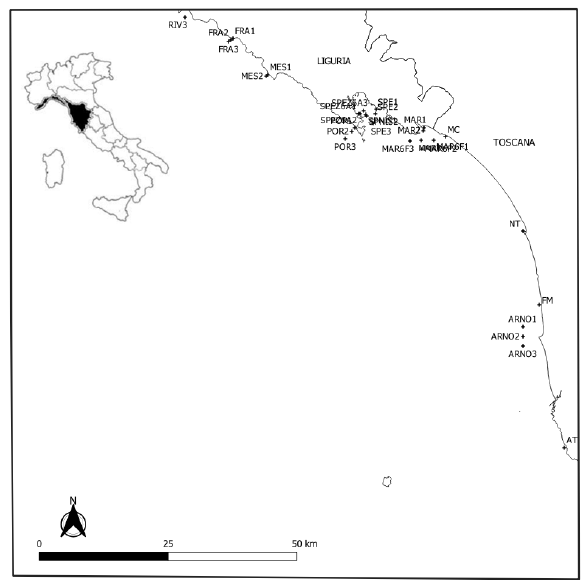
Figure 2. Monitoring stations within the study area. was measured in nephelometric turbidity units (NTU). At each station, turbidity profiles were conducted from the surface to the bottom, the average value at 0.5 m from the surface was used for the present study. Turbidity measurements include data from 2015 to 2021 and considered values range from 0.2 NTU to 28.7